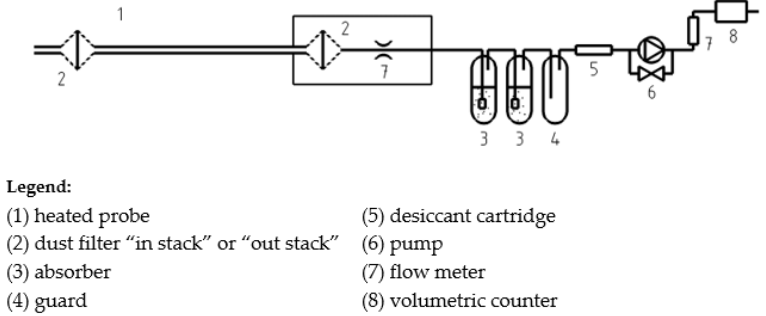
Figure 1. Scheme of integral low-flow sampling.